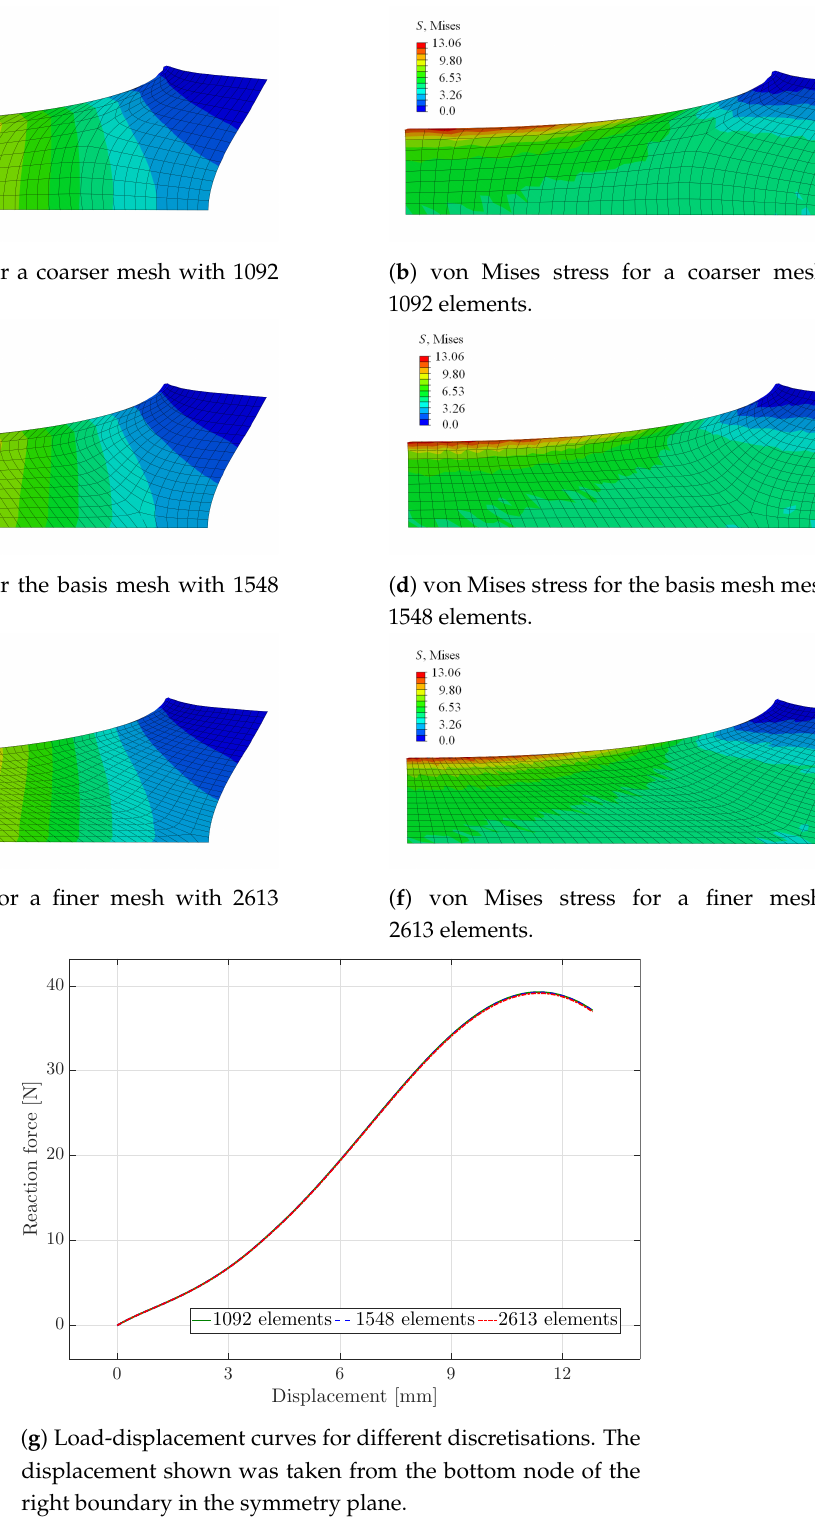
Figure 11. Contour plots of the damage function values and the von Mises stress, as well as load-displacement curves regarding the parameter set Final #1 for different